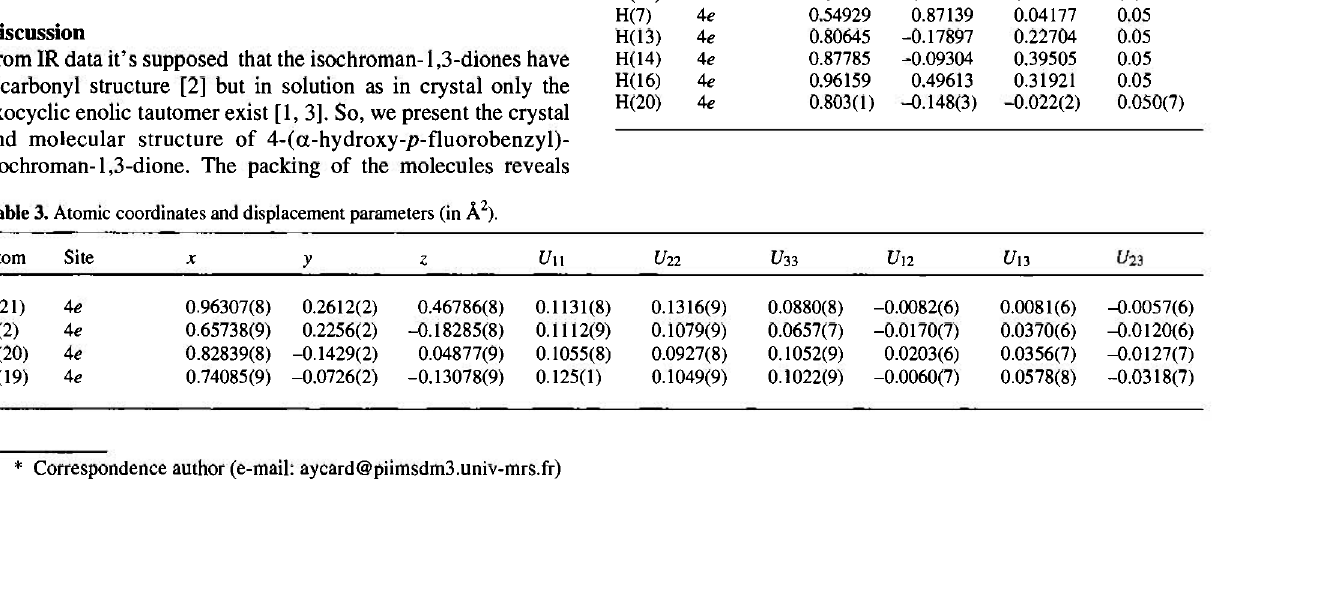
Table 2. Atomic coordinates and displacement parameters (in A